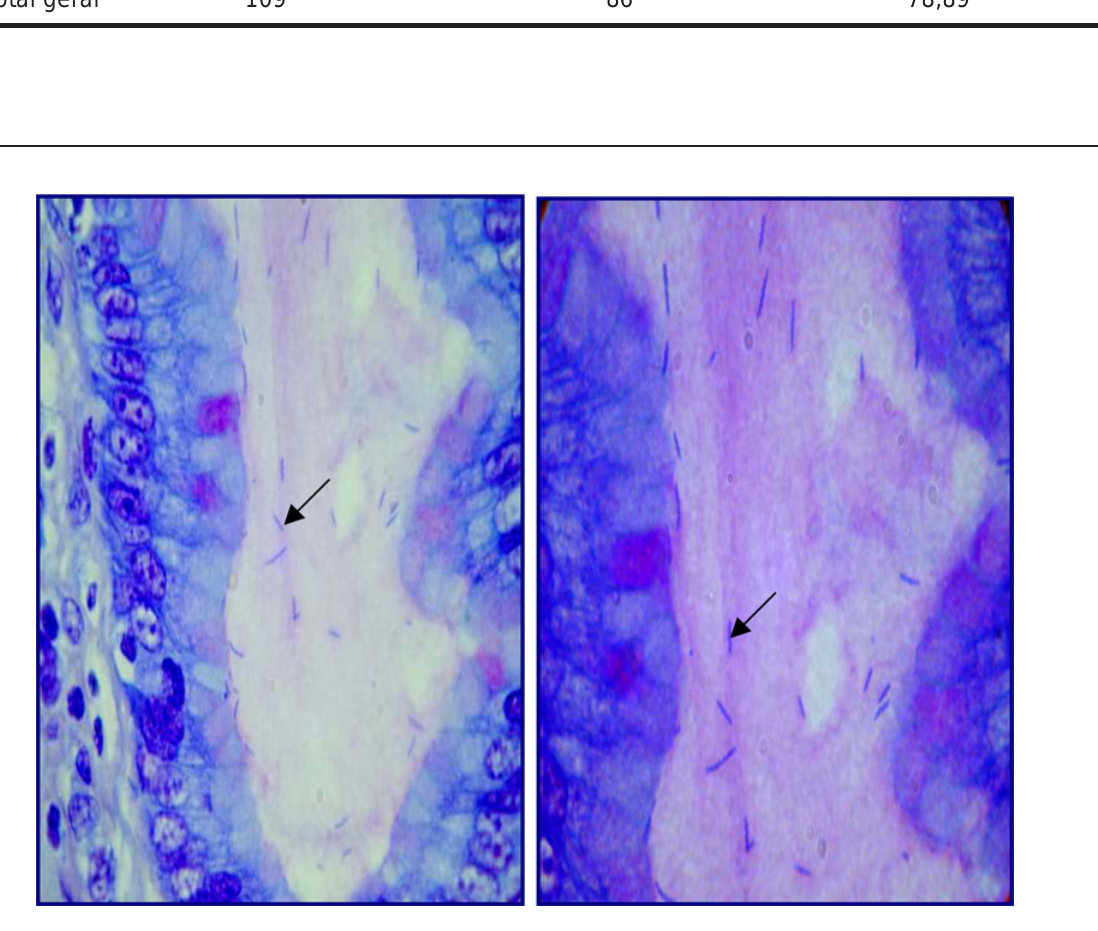
FIGURA 1 - Microscopia de imersão. Bactérias alongadas e espiraladas, tipo “saca-rolhas” nas criptas